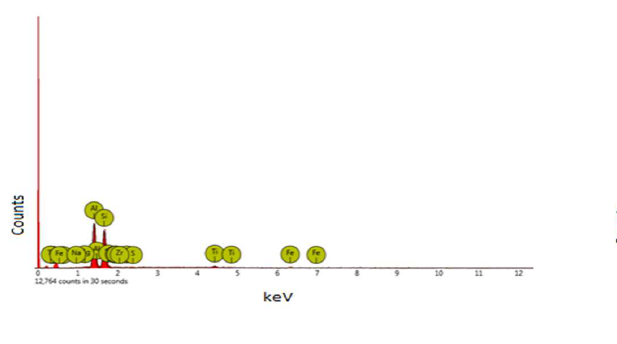
Figure 5. SEM ( a ) kaolin ( b ) Metakaolin.